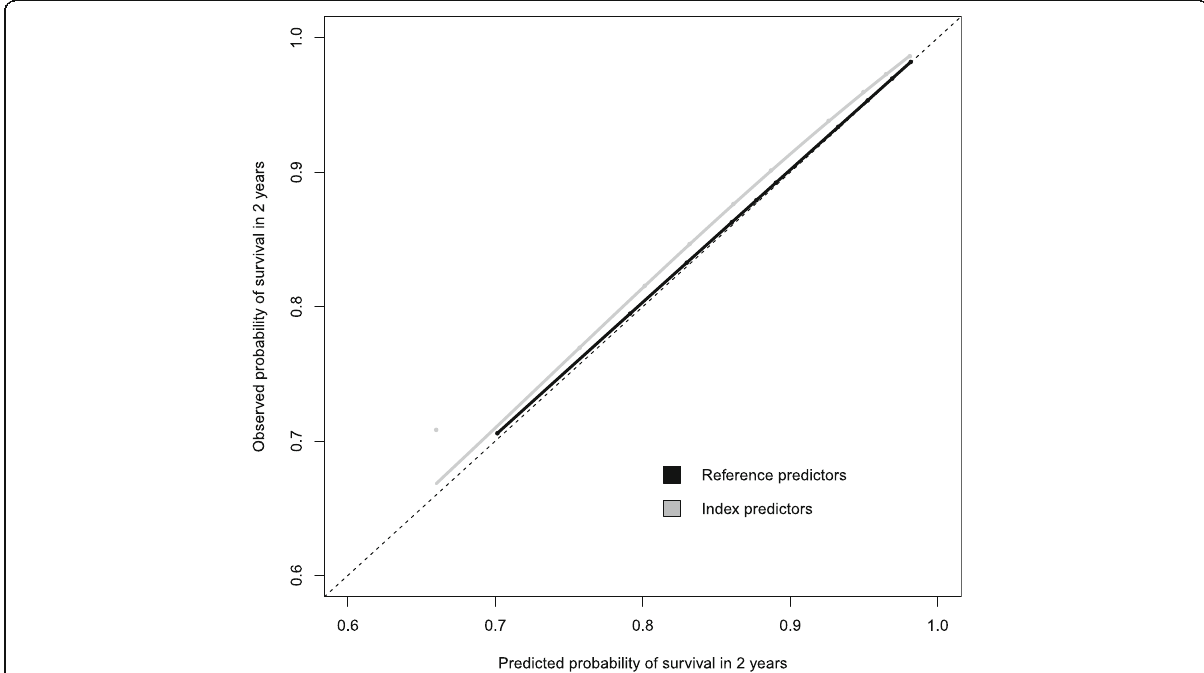
Fig. 2 Calibration plot showing deciles of observed and predicted probabilities of survival from the CHA2DS2-VASc model developed using the reference predictors and validated using the baseline hazard and coefficients for validation with the index predictors as input